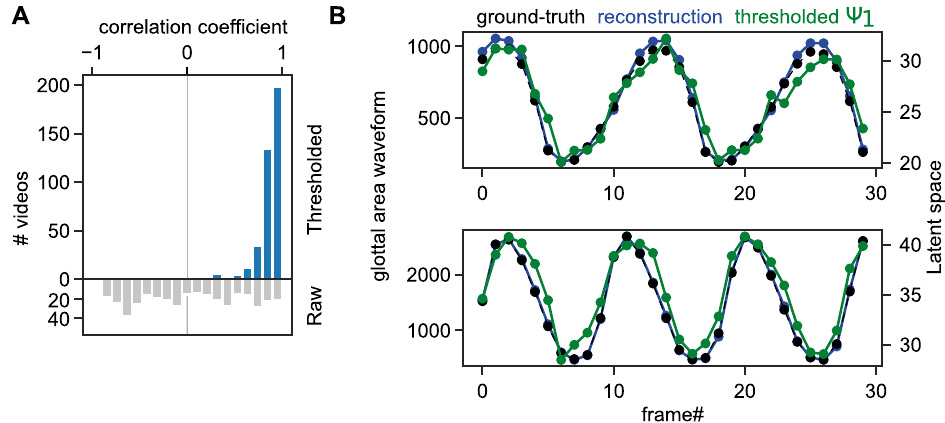
Figure 3. Thresholded latent space image (cid:31) 1 is highly correlated with glottal area waveform. ( A ) Distribution of correlation values across videos using either the raw latent space image (cid:31) 1 or the thresholded (cid:31) 1 using the 95% confidence interval as threshold (see Fig. 2A). Correlation was computed from every latent space to glottal area waveform of 30 frames ( N = 399 videos). ( B ) Two exemplary videos showing the original ground-truth glottal area waveform (GAW, black), the segmentation prediction of the deep neural network with a single latent channel (blue) and the thresholded latent space image (cid:31) 1 from the same network (green).